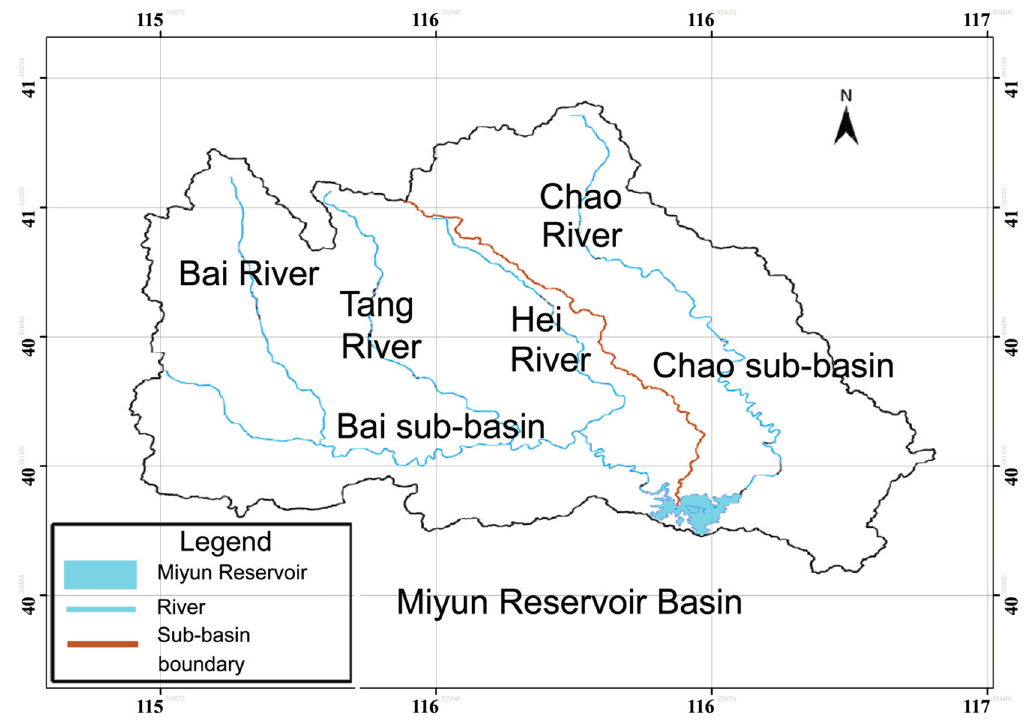
Figure 1. The Miyun Reservoir in northern